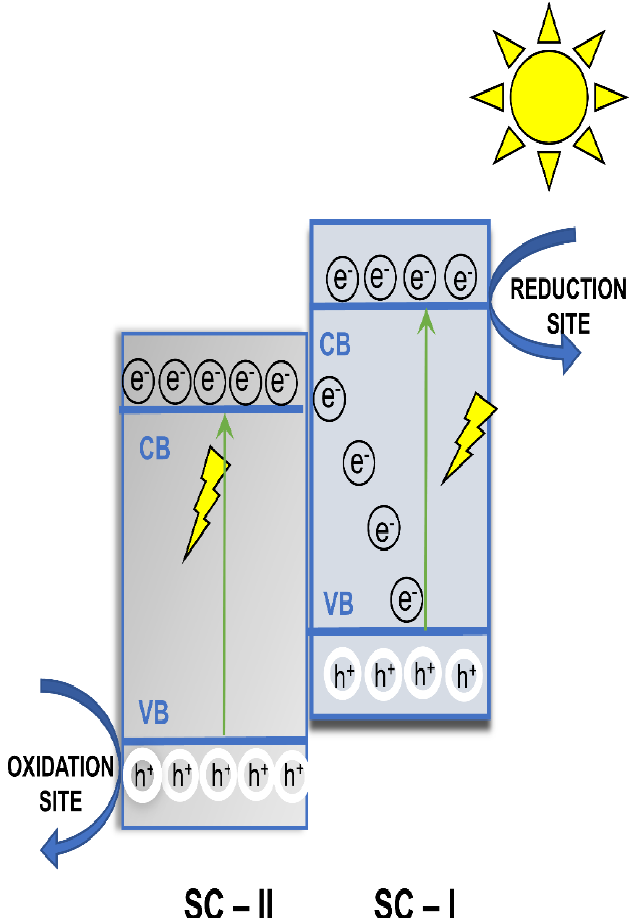
Figure 10. Z–Scheme of [119] Adapted with permission from Elevier, Journal of Industrial and En- gineering Chemistry , An overview of converting reductive photocatalyst into all solid-state and direct Z-scheme system for water splitting and CO 2 reduction, Raizada P. et al., License Number: 5391800879853, 2021.